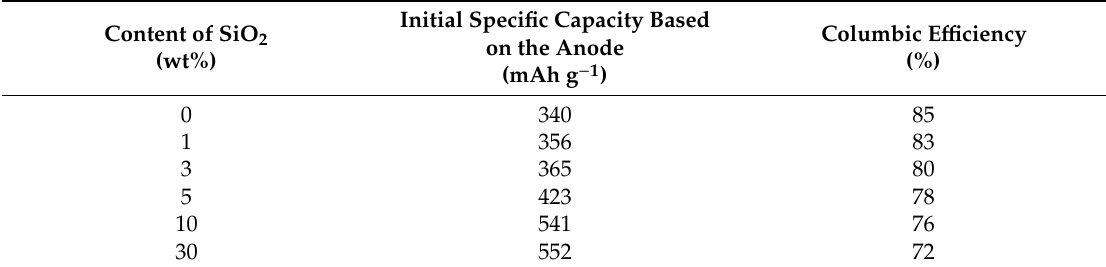
Table 2. Initial specific capacity of the SiO 2 / C